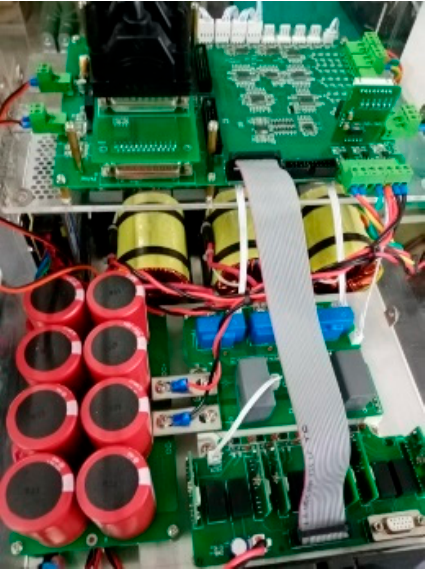
Figure 11. The single-phase H-bridge experimental prototype.